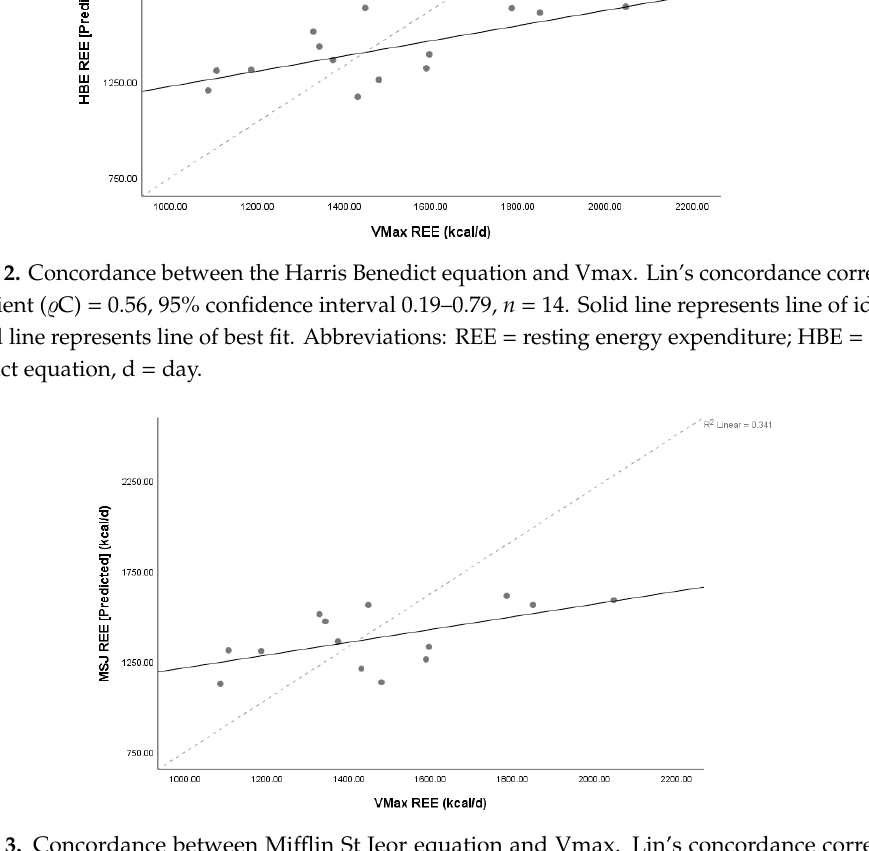
Figure 3. Concordance between Mi ffl in St Jeor equation and Vmax. Lin’s concordance correlation Figure 3. Concordance between Mifflin St Jeor equation and Vmax. Lin’s concordance correlation Figure 3. Concordance between Mifflin St Jeor equation and Vmax. Lin’s concordance correlation coe ffi cient ( (cid:37) C) = 0.47, 95% confidence interval 0.07–0.75, n = 14. Solid line represents line of identity, coefficient ( ρ C) = 0.47, 95% confidence interval 0.07–0.75, n = 14. Solid line represents line of identity, coefficient ( ρ C) = 0.47, 95% confidence interval 0.07–0.75, n = 14. Solid line represents line of identity, dashed line represents line of best fit. Abbreviations: REE = resting energy expenditure; MSJ = Mi ffl in Figure 3. Concordance between Mifflin St Jeor equation and Vmax. Lin’s concordance correlation dashed line represents line of best fit. Abbreviations: REE = resting energy expenditure; MSJ = Mifflin dashed line represents line of best fit. Abbreviations: REE = resting energy expenditure; MSJ = Mifflin St. Jeor equation, d = coefficient ( ρ C) = 0.47, 95% confidence interval 0.07–0.75, n = 14. Solid line represents line of identity, St. Jeor equation, d = day. St. Jeor equation, d = day. dashed line represents line of best fit. Abbreviations: REE = resting energy expenditure; MSJ = Mifflin St. Jeor equation, d = day.